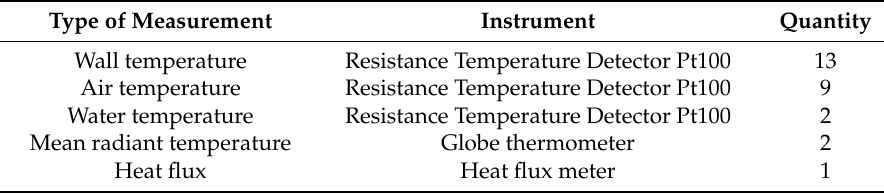
Table 3. Sensors positioned inside and outside the test